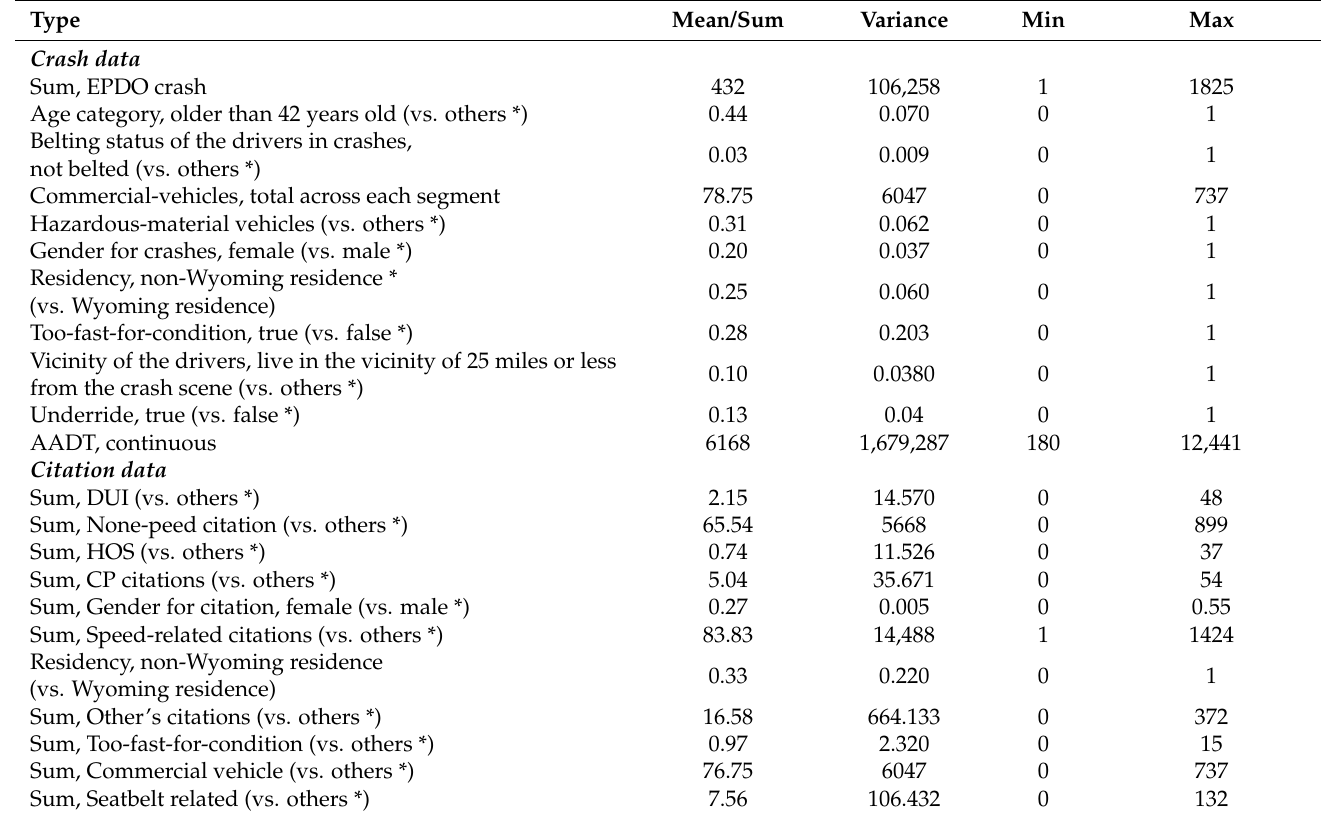
Table 1. Descriptive summary of important predictors related to citations and